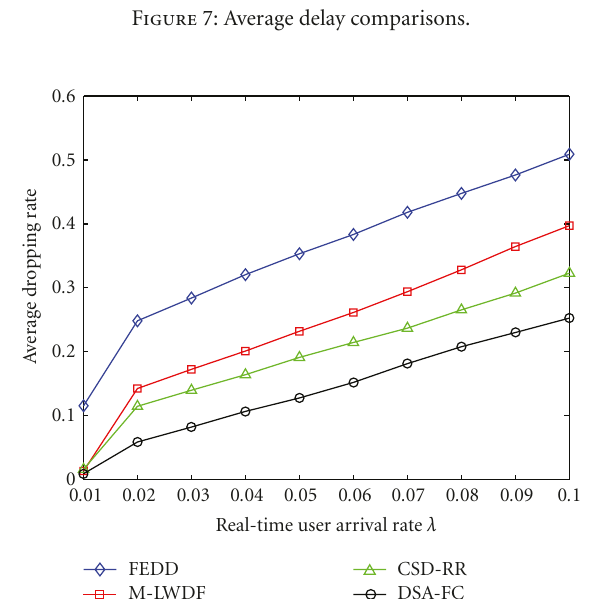
Figure 8: Dropping rate